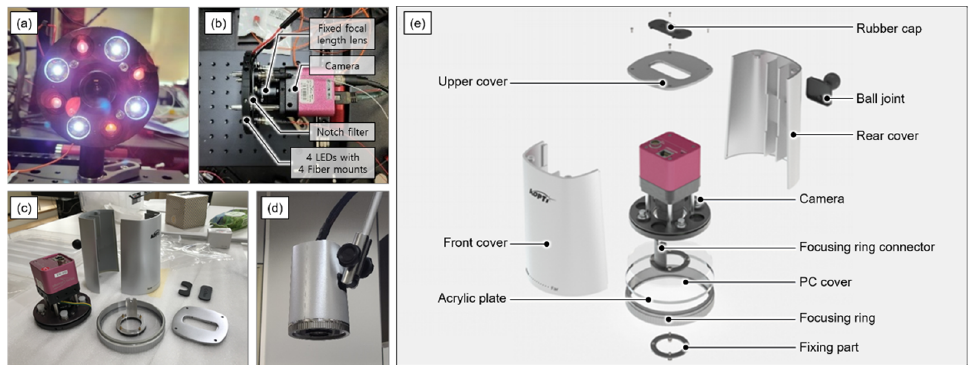
Figure 2. Imaging head of the system. ( a ) illumination plate for 4 white LEDs and 4 fiber mounts ( b ) Illumination and image acquisition parts. ( c ) Parts of imaging head ( d ) Imaging head assembled with four joint arms. ( e ) detailed parts of the imaging head case.